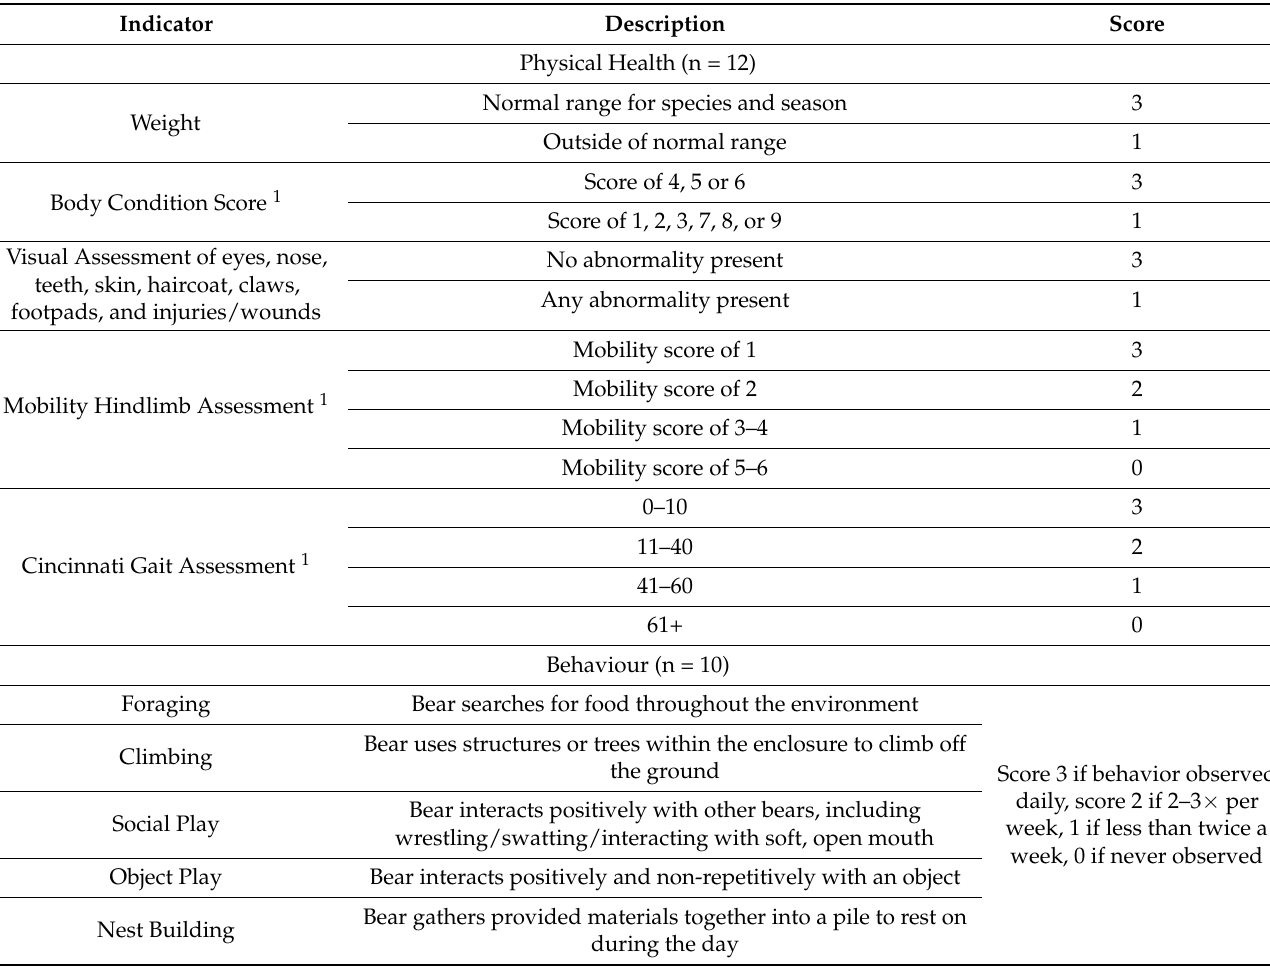
Table 1. Welfare assessment indicators with their corresponding definitions and scoring system.